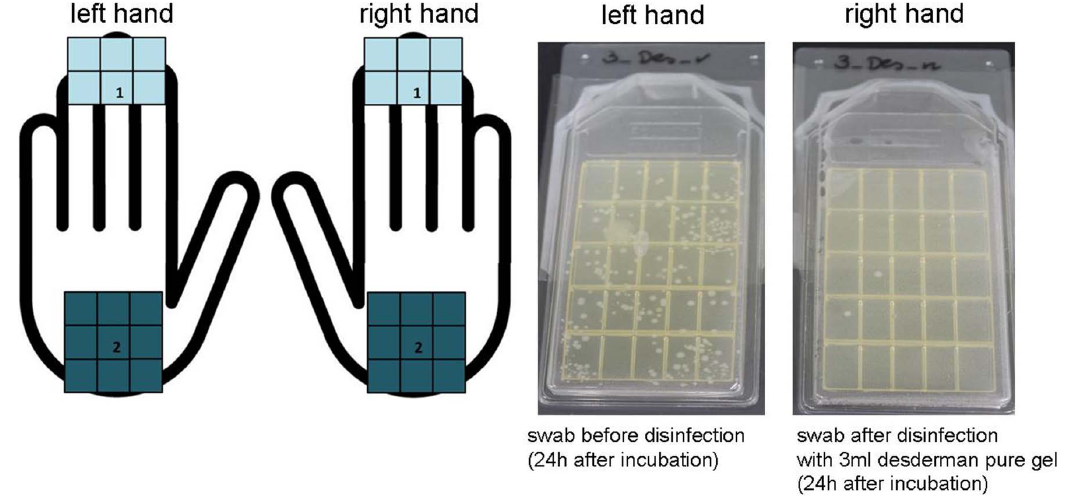
Figure 3. Standardized localisation for taking swabs of finger tips and hand palm before and after disinfection. (a) Agar plates with swabs of finger tips and hand palm before and after disinfection with desderman pure gel (phase 1); 24 h incubation at 35 u C. (b).